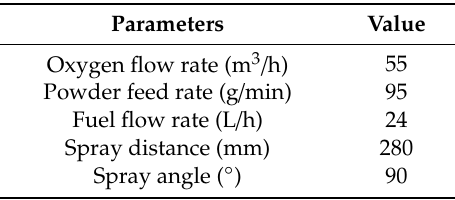
Table 1. Main parameters used for HVOF